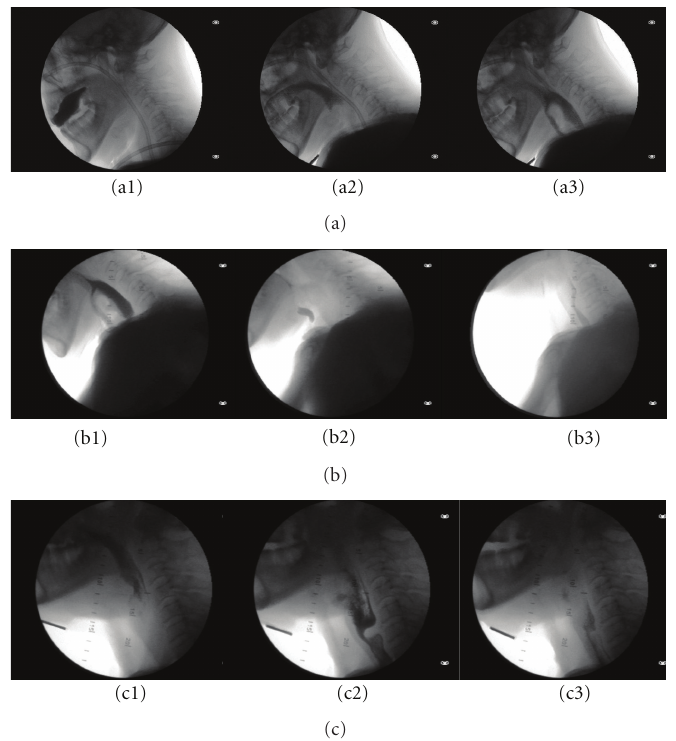
Figure 6: Case report 2. Male, 64. T2 bilateral glottic epidermoid carcinoma a ff ecting the right laryngeal ventricle and with limited extension to the subglottis. He received a supracricoid laryngectomy with cricohyoidopexy and bilateral functional neck dissection. The sequence of postoperative videofluoroscopic examinations is presented. (a) Early postoperative (10 days) with noticeable aspiration (a3). The patient received a temporary gastrostomy and was instructed in swallowing maneuvers (chin-chest, supraglottic swallow, e ff ortful swallow, and repeated swallow), and was advised to do exercises with honey-pudding consistency. (b) In a 3-month videofluoroscopic control there is penetration (b1) with residue in the laryngeal vestibule (b2) that is cleared by voluntary coughing and repeated swallow (b3). (c) Three months postop: the larynx and the trachea are free of alimentary contents. Note the typical cricopharyngeal bar (c2). Deglutition is e ff ective and safe